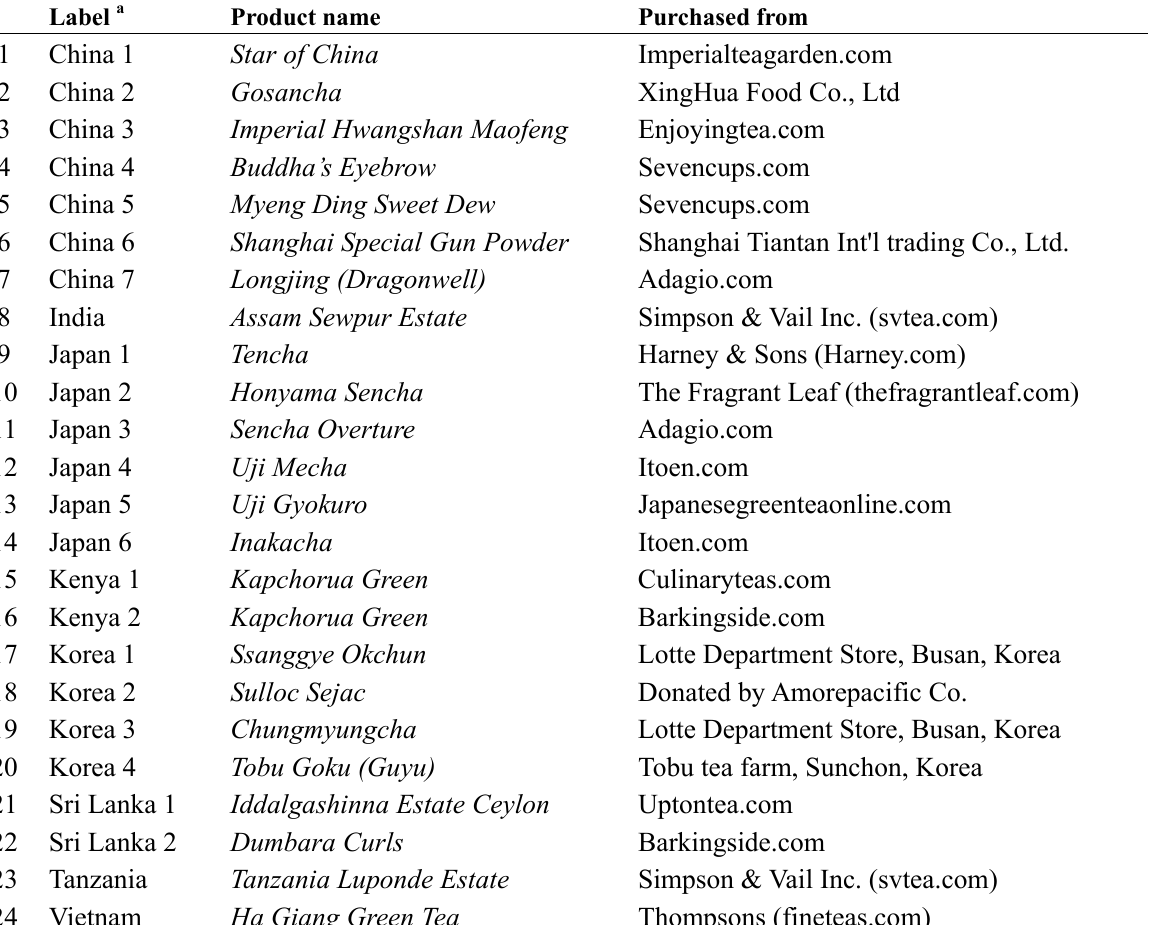
Table 4. List of 24 green tea